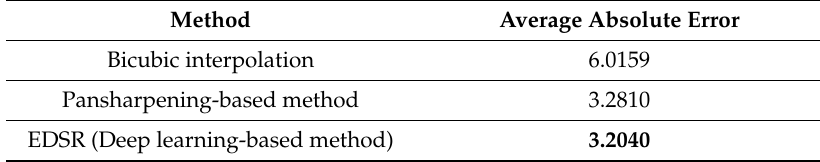
Table 5. Average absolute error on disparity maps for the foreground image part of the motorcycle image section. Bold format indicates the method providing better